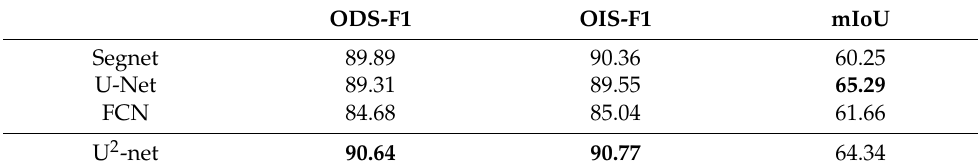
Table 4. Experimental results on the WHU dataset with semantic segmentation